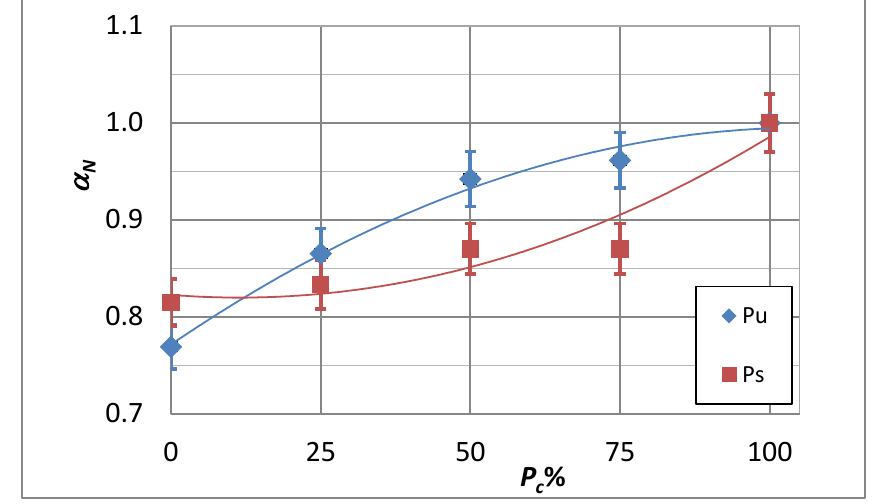
, versus P % for both Pu and Ps coupon N c